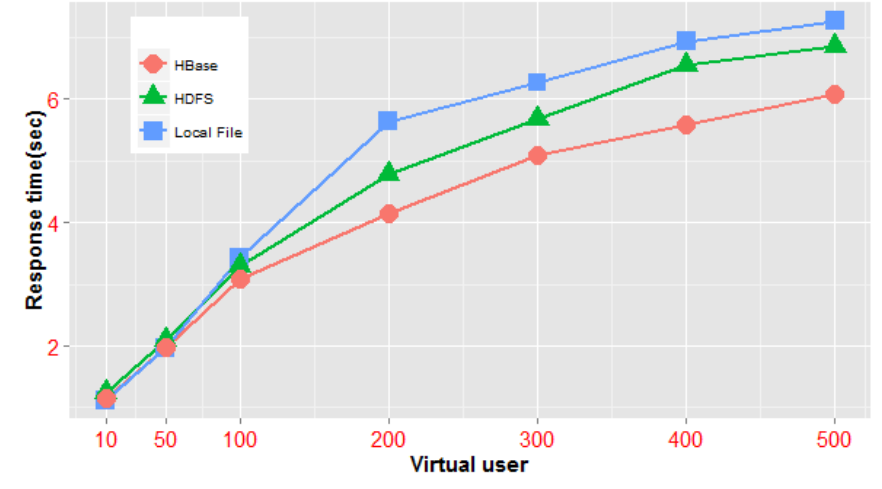
Figure 18. Response time of a cross-level rectangle-range query.